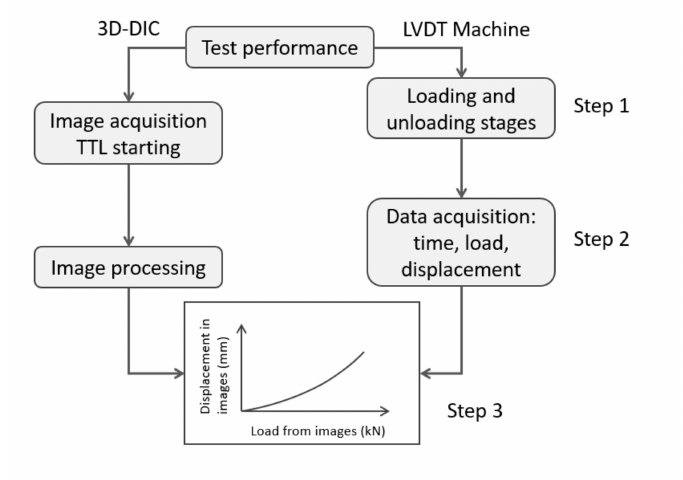
Figure 3. Flow chart illustrating the implemented experimental methodology to extract test results.